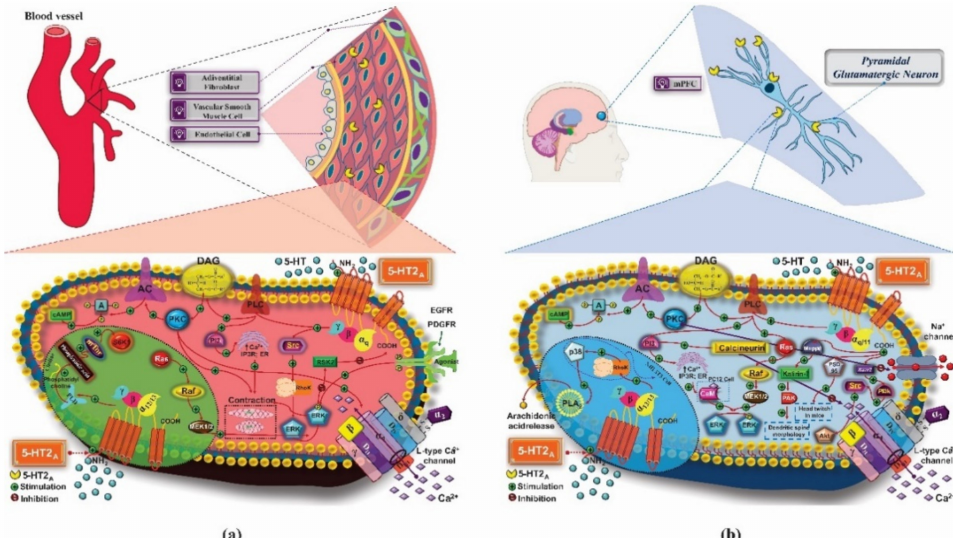
Figure 5. 5-HT 2A receptor signaling pathways: ( a ) In blood vessels (and other smooth muscles), stimulation of the 5- HT 2A by 5-HT receptor activates several signal transduction pathways through the G α q/11 protein (phospholipase C (PLC)/Diacylglycerol (DAG)/protein kinase C (PKC)/calcium (Ca 2+ ) and kinase phosphorylation regulated by extracellular signal (ERK), leading to vascular smooth muscle contraction. The “atypical” coupling represented by the green circle demonstrates the specific signaling of the tracheal tissue mediated by the 5-HT 2A receptor, corroborating the hypothesis that the activity of these receptors, as well as the integration of their multiple pathways, varies from one tissue to another. In the trachea, activation of the 5-HT 2A receptor produces its downstream effects primarily through the mammalian target of rapamycin (mTOR)/p70 ribosomal protein S6 kinase (S6K1) pathway [12]. ( b ) In glutamatergic neurons of the medial prefrontal cortex (mPFC), the coupling of 5-HT to the 5-HT 2A receptor stimulates the G α q/11 protein that activates several signal transduction pathways through PLC/DAG/AC/PKC. These, in turn, produce inhibition of Ca 2+ and Na + conductances. The “atypical” coupling represented by the blue circle demonstrates the activation of phospholipase A2 (PLA 2 ) mediated by the 5-HT 2A receptor and the subsequent release of arachidonic acid, described as a result of G α 12/13 - coupled, Rho-mediated, p38 activation in NIH 3T3 cells [48]. Stimulation of PLA 2 causes the release of arachidonic acid. The pathways of several kinases are involved in the modulation of neuron morphology and plasticity through direct interaction between the C terminal portion of the receptor and specific modulating proteins